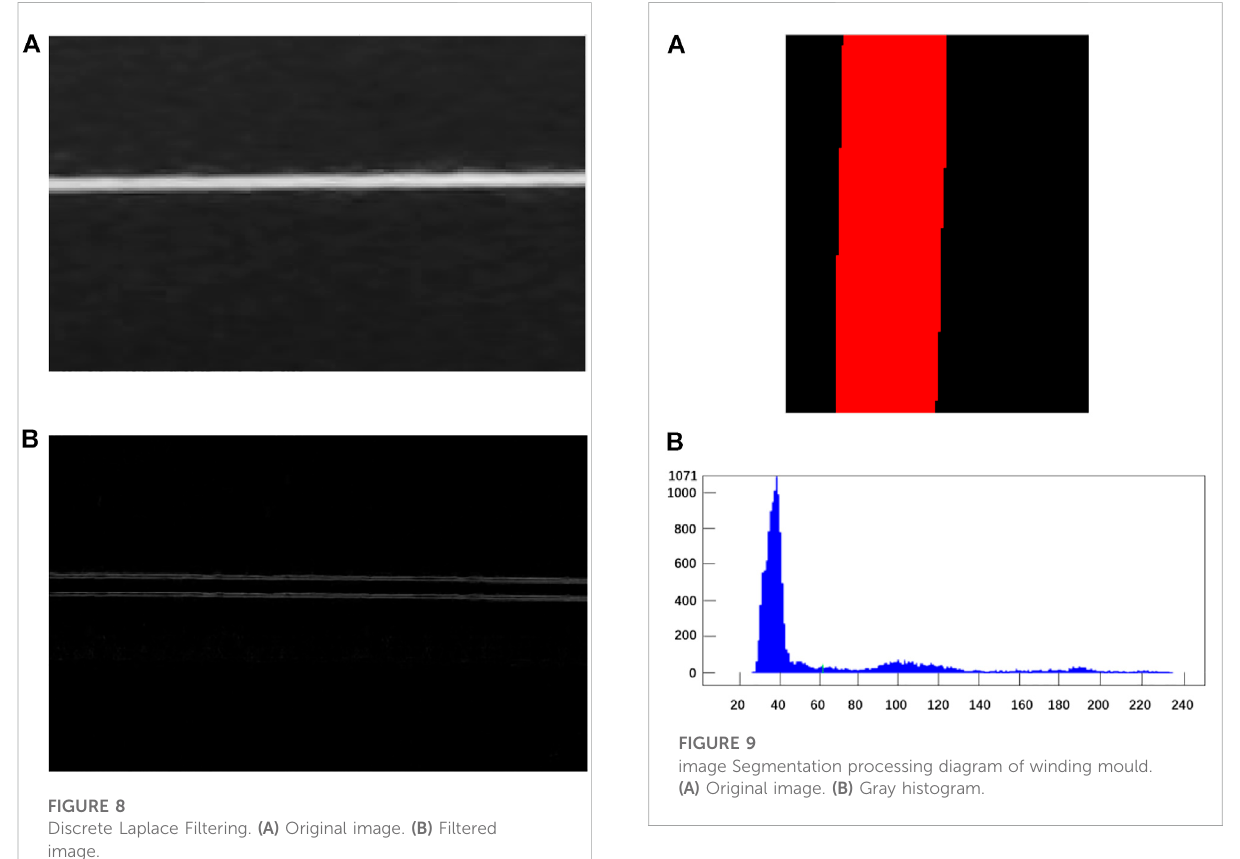
FIGURE 8 Discrete Laplace Filtering. (A) Original image. (B) Filtered image.